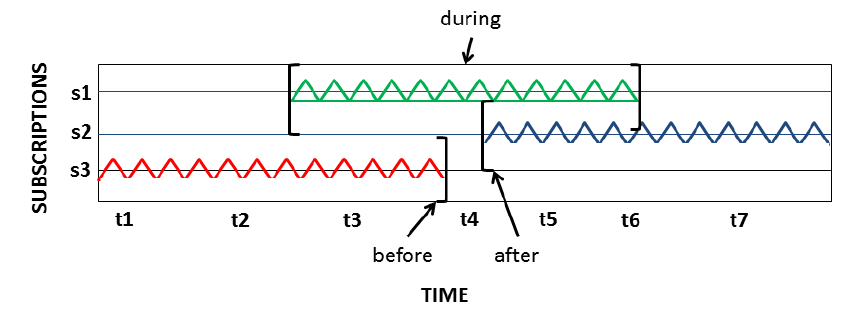
Figure 6. Filtering sensors using time as a